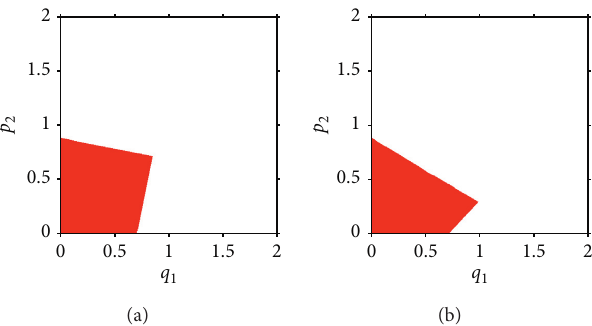
Figure 12: Basins of attraction of the dynamic system (12) when α � β � 1 . 5. (a) c � 0 . 2. (b) d � 0 . 6